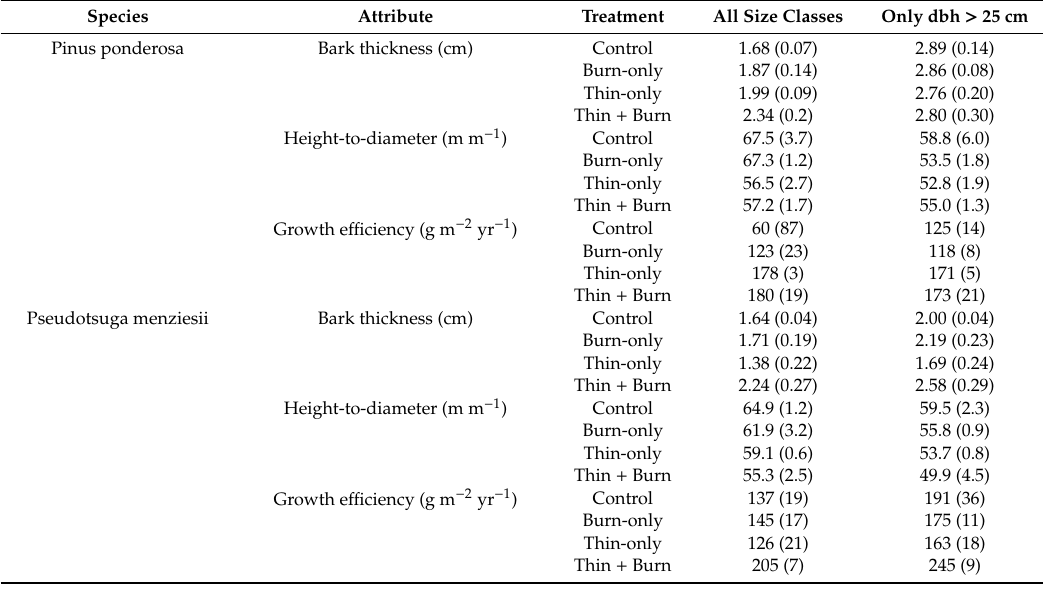
Table 2. Average tree resistance attributes by treatment. Mean and 1 standard error shown.